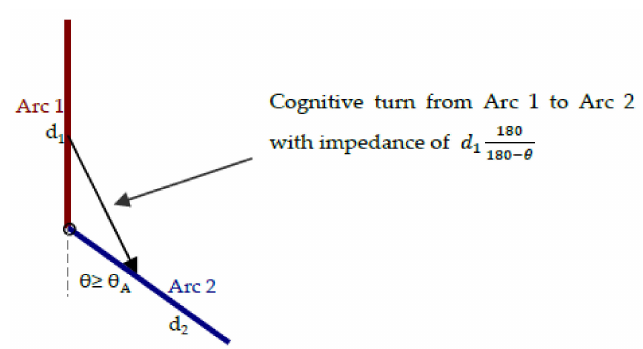
Figure 6. Metric-weighted angular turn